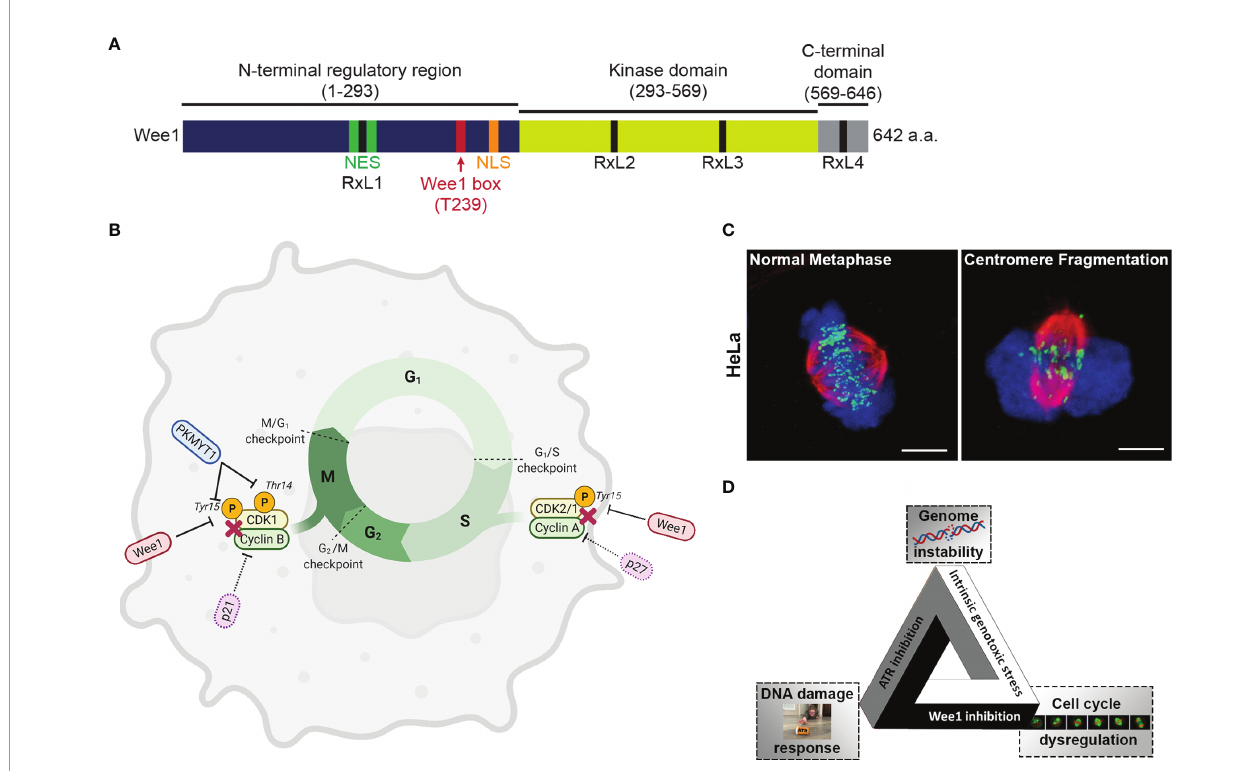
FIGURE 1 | (A) The 642 amino acid long protein kinase Wee1 contains a N-terminal regulatory domain (dark blue), a kinase domain (yellow green), and a short C-terminal domain (gray). The diagram also shows a nuclear localization sequence (NLS; orange), a nuclear export sequence (NES; green), a highly conserved regulatory Wee1 box (red), and four cyclin binding motifs (RxL1, RxL2, RxL3, and RxL4; black). (B) Regulation of the cell cycle via phosphorylation of Cyclin- Dependent Kinases (CDKs) by Wee1 and the related protein kinase MYT1. (C) Images of HeLa cells in metaphase undergoing unperturbed mitosis or centromere fragmentation due to mitotic catastrophe as a result of premature entry into mitosis. (chromosomes, blue; tubulin, red; centromeres, green) (D) The fateful triangle underlying the conditional synthetic lethality observed in cancer cells leading to selective killing by combined ATR and Wee1